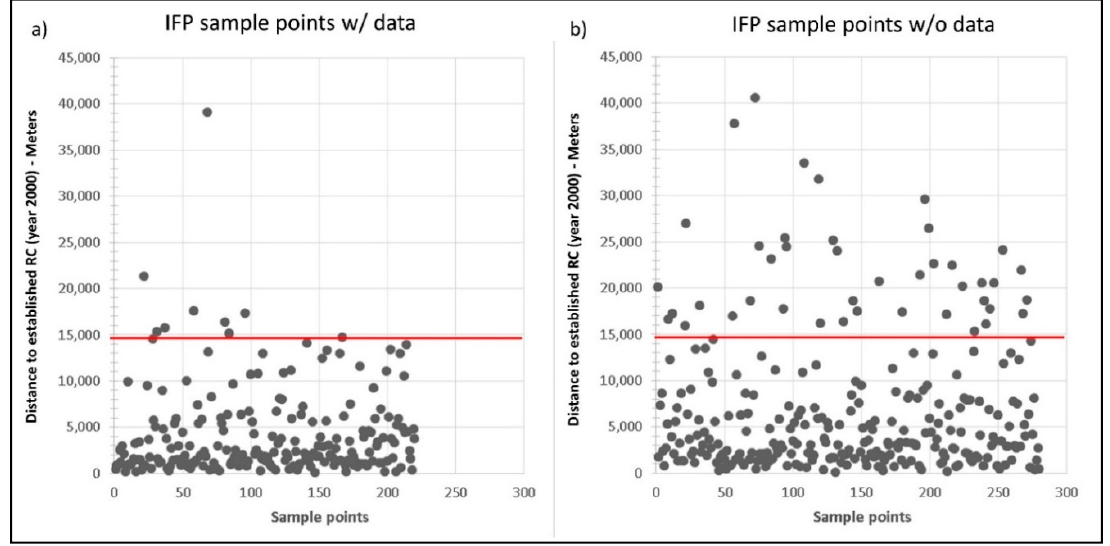
Figure 13. IFP sample points by distance to the established rural complex: ( a ) IFP w/data, ( b ) IFP w/o data. The red line shows the 15 km mark for reference.